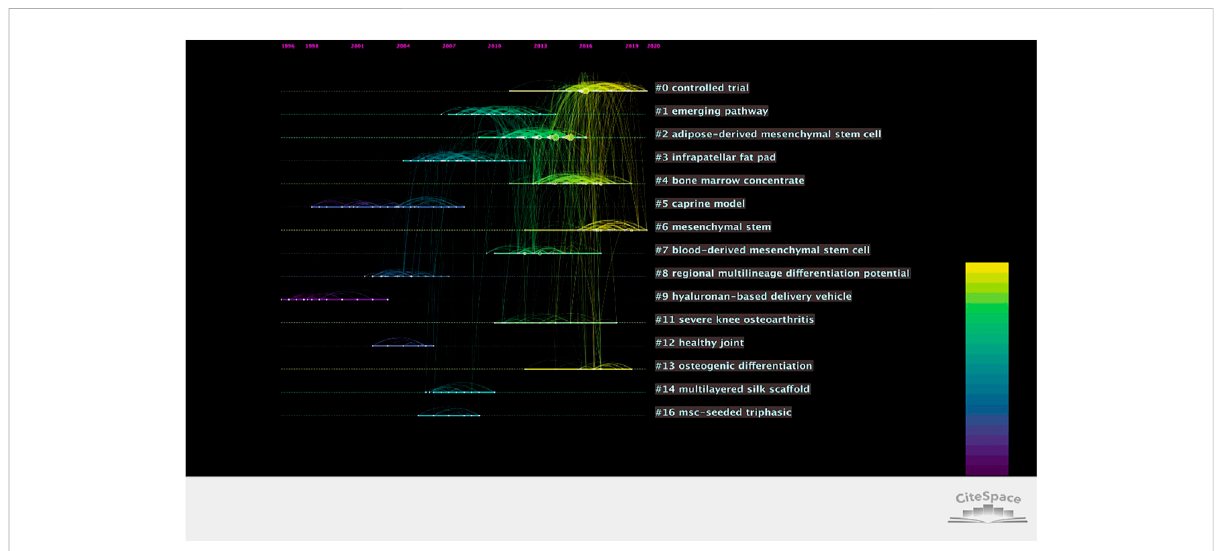
FIGURE 10 Time evolution analysis for co-cited references for stem cell therapy in KOA research. The color indicates the publication year. Colored curves representco-citationlinksaddedfortheyearofthecorrespondingcolor.Largenodesindicateeitherlargenumbersofcitations,presenceofcitation bursts, or both. Vertically descending order indicates cluster size. The publication year is indicated above the map.